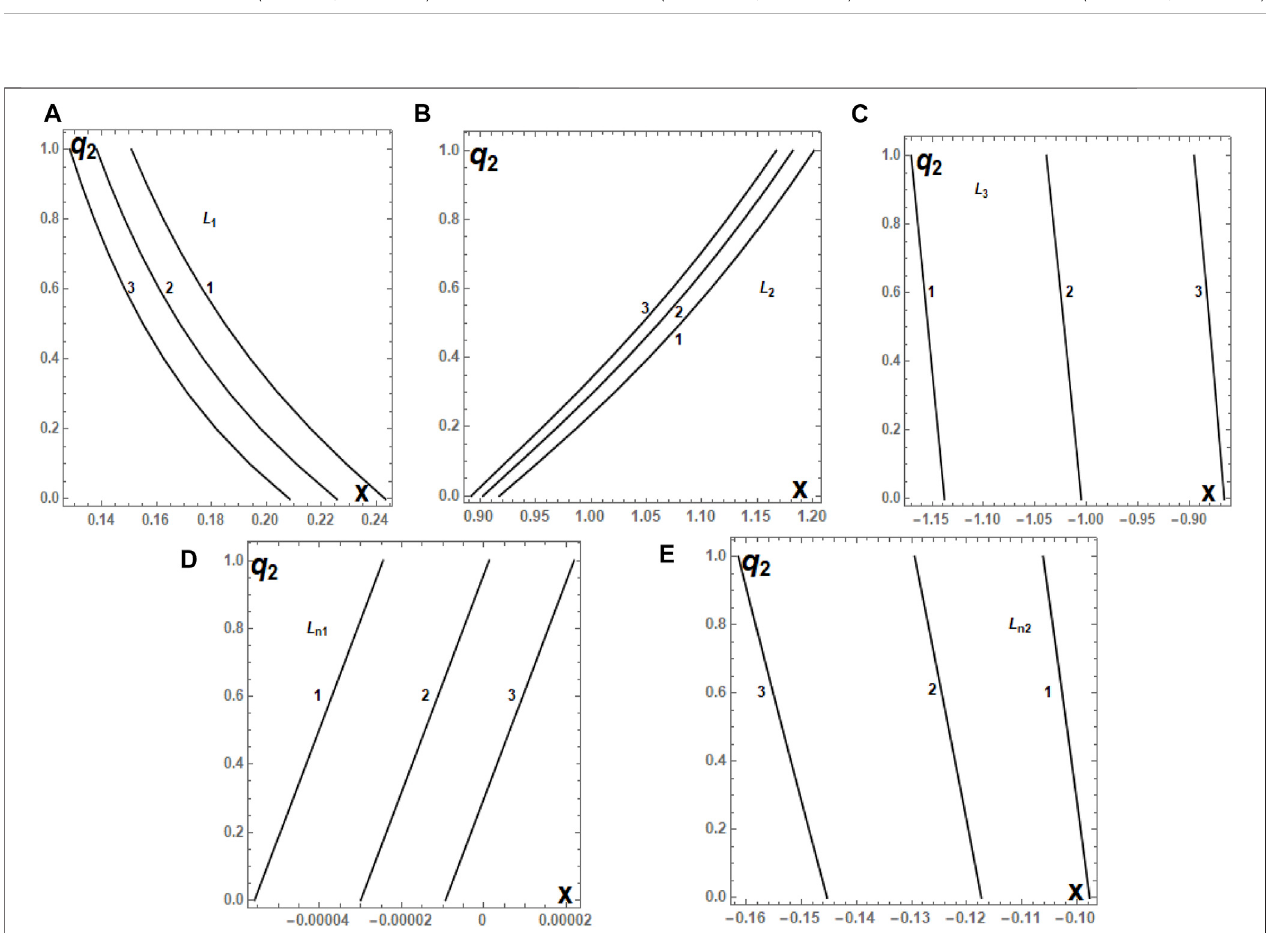
FIGURE5|(A – E) Positions ofthecollinearequilibriumpoints L i , i =1,2,3, L nj , j =1, 2,oftheHD11565system, asafunction of q 2 , whichvaries inthe interval(0, 1] for fi xed values of q 1 equal to 1 (1), 0.5 (2), and 0.1 (3). The disc, oblateness, and triaxiality parameters are kept as constants as given in Table 2 . The numbering of equilibrium points is according to the diagram shown in Figure 2 .